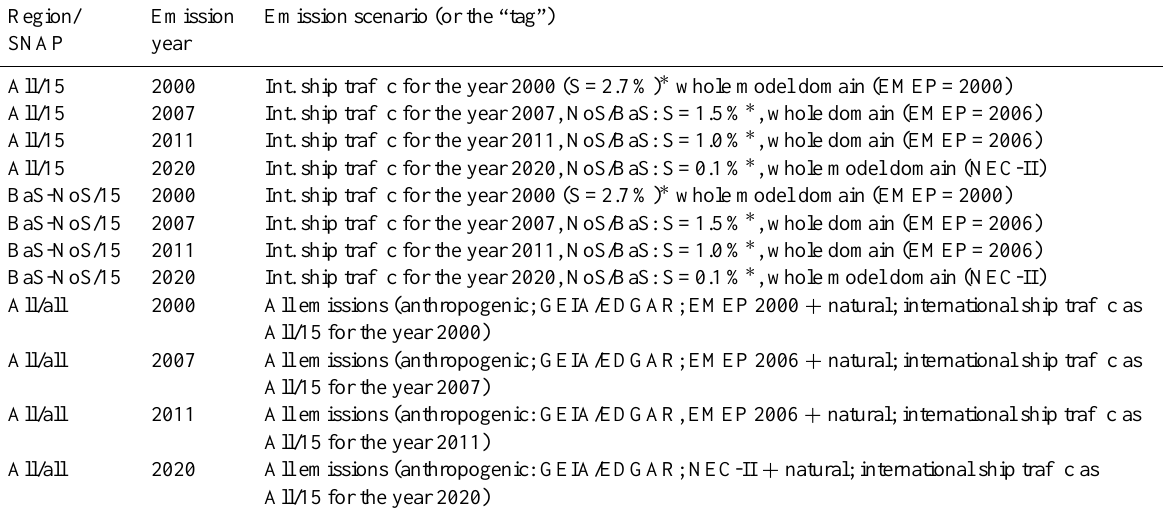
Table 1. Definition of the specific scenarios (or “tags” in the model). Each scenario is defined by a region and a SNAP category (first column), an emission year (second column), and a short description of the emissions of interest in the scenario (column